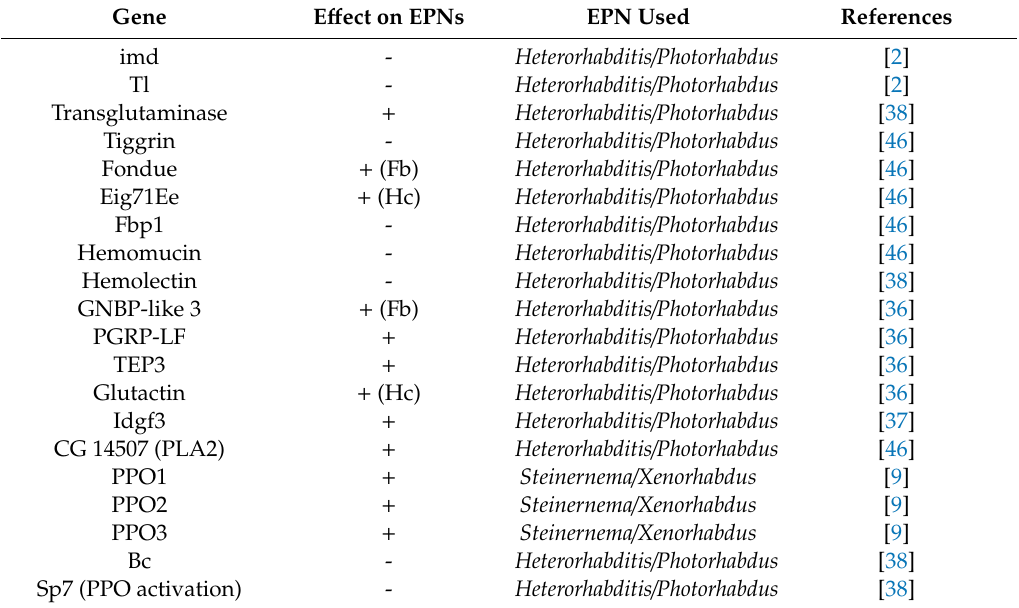
Table A1. Drosophila genes tested for their e ff ects upon infection with EPNs ( + : e ff ects were observed;